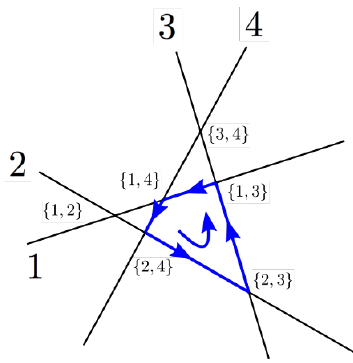
Figure 5 . The quadrilateral depicted in (cid:12)gure 3 de(cid:12)ned solely through the intersection of its faces. these vertex objects are antisymmetric, so that F